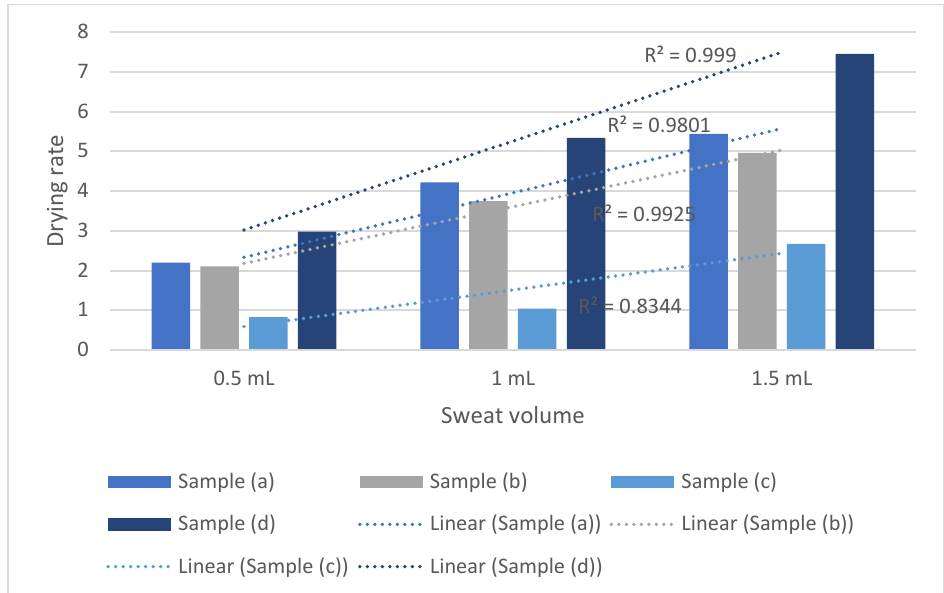
Figure 4. Sweat drying performance of protective fabrics at 0.5 m/s ambient air speed.